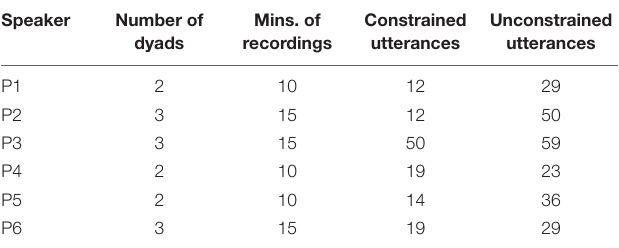
TABLE 1 | Speaker-specific